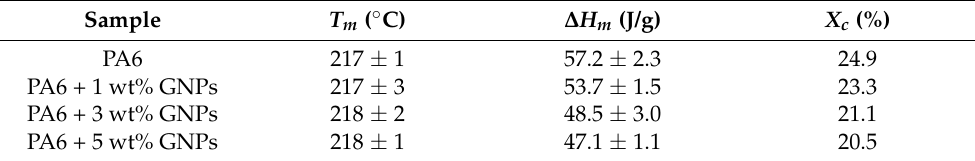
Table 1. Calorimetric parameters.